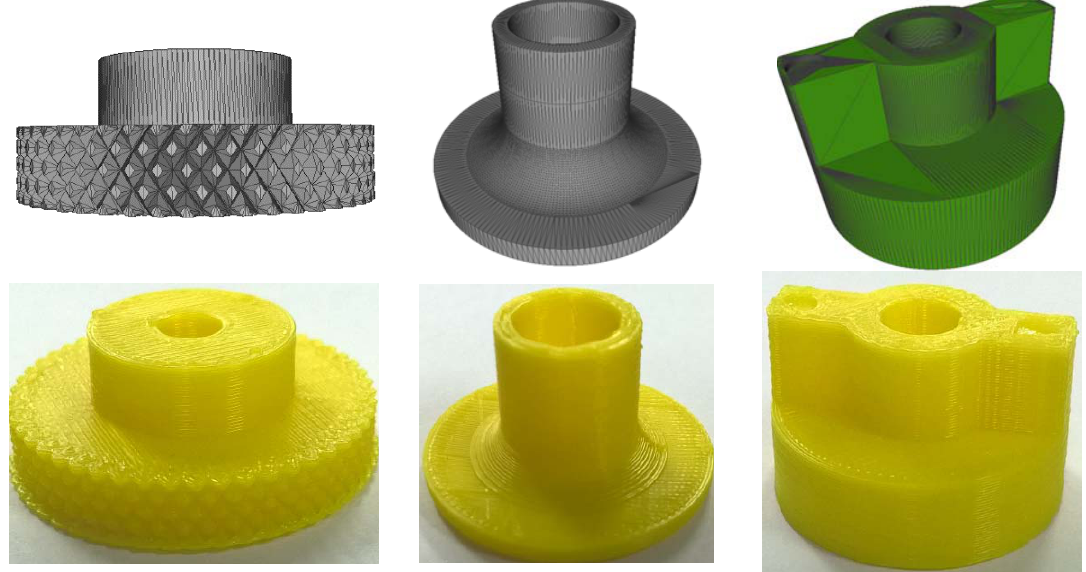
Figure 7. 3D printed objects.